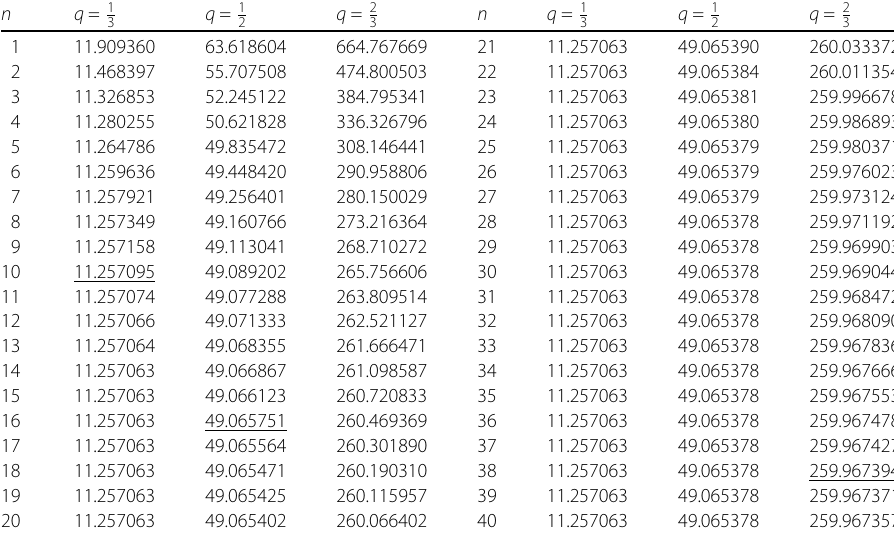
, 1 , 2 and n = 1,2, ... ,40 3 2 3